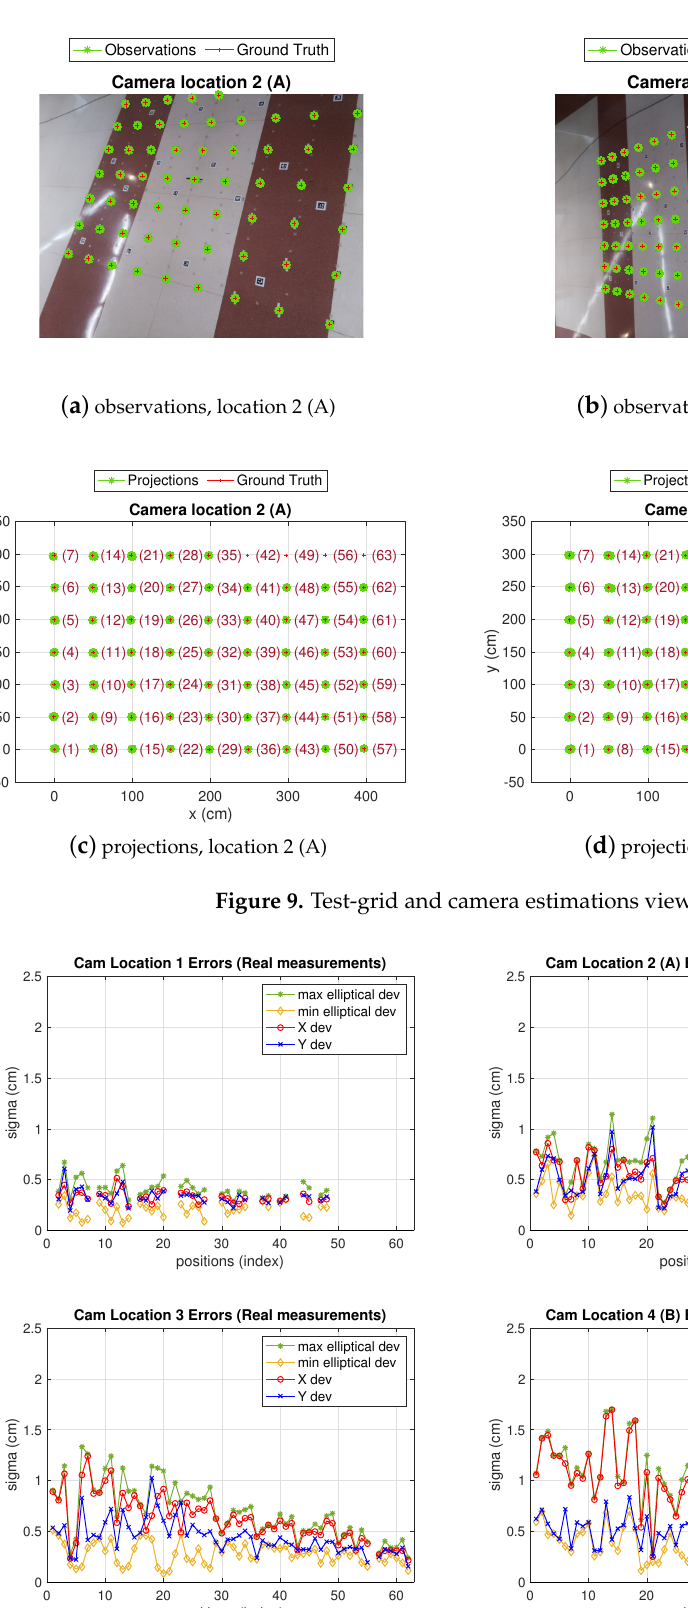
Figure 10. Camera sensor positioning errors (Real